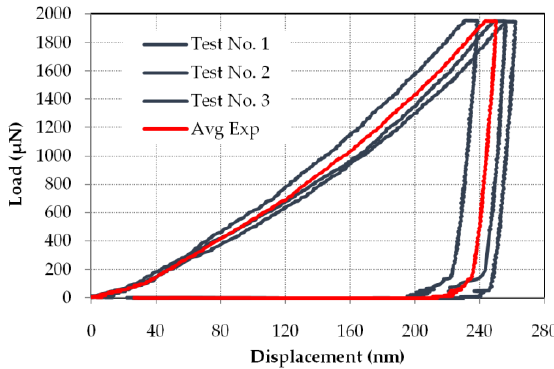
Figure 5. Load/unload–displacement curves of aluminum 1100 under nanoindentation tests.